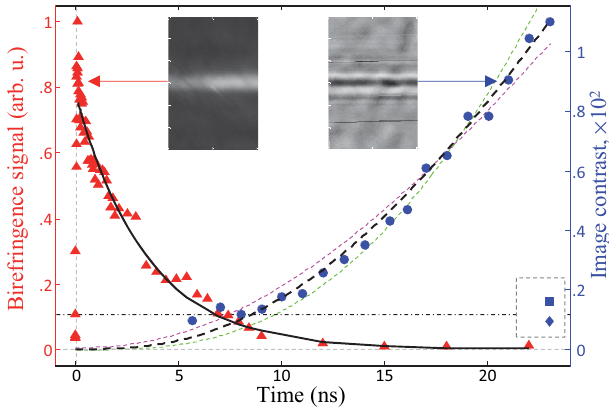
FIG. 3. Birefringence signal (red triangles) and phase contrast (blue circles) of the centrifuged gas, retrieved from the transverse images taken with and without the crossed polarizers (left and right insets, respectively) and plotted as a function of the delay time between the centrifuge and probe pulses. Optical birefrin- gence is induced by the centrifuge instantaneously and falls off exponentially with a time constant of 3.4 ns (solid black curve, fit at τ ≥ 100 ps, i.e., after the end of the centrifuge pulse). Two data points in the lower right corner (within the dashed rectangle) indicate the drop in the phase contrast for the slower rotating centrifuge. The dashed black line is a fit to the hydrodynamic numerical calculations of Δ n ð τ Þ with a RT exchange rate of 3.4 ns, whereas the dashed magenta and green lines represent the best fits with the rate constant being 5 times shorter and longer, respectively. The horizontal dash-dotted line indicates the noise floor for the phase contrast